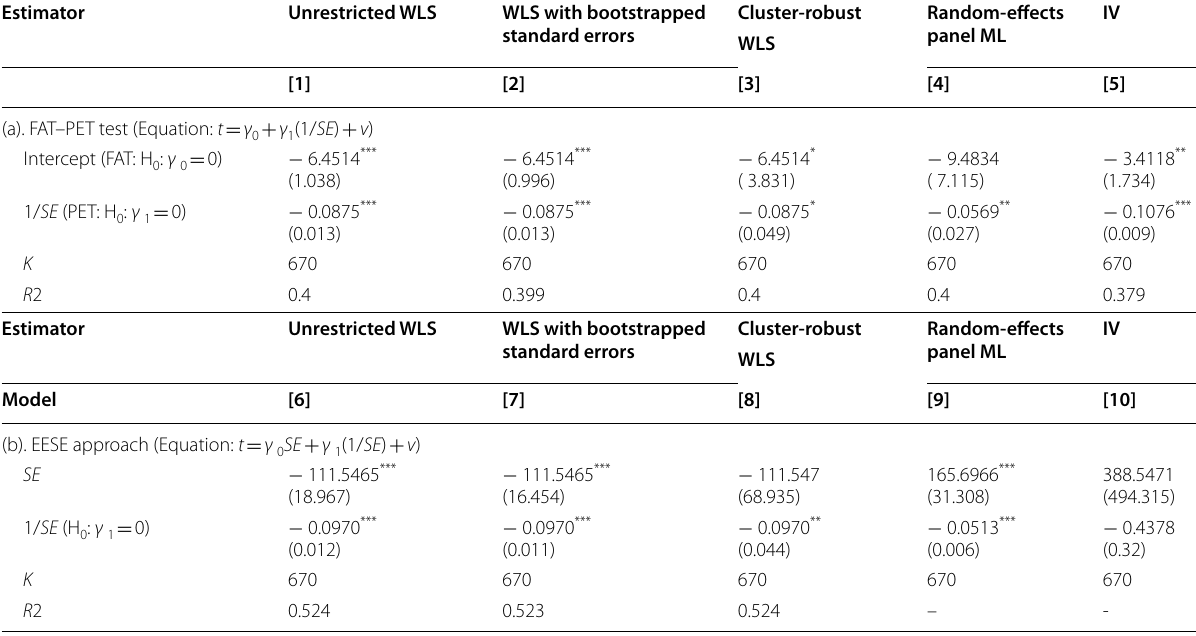
Table 6 Meta-regression analysis of publication selection bias: All studies